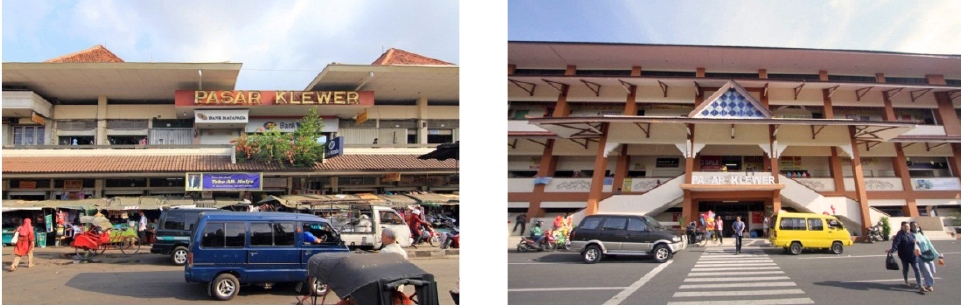
Figure 3. Pasar Klewer conditions (Kota Surakarta, March 22,